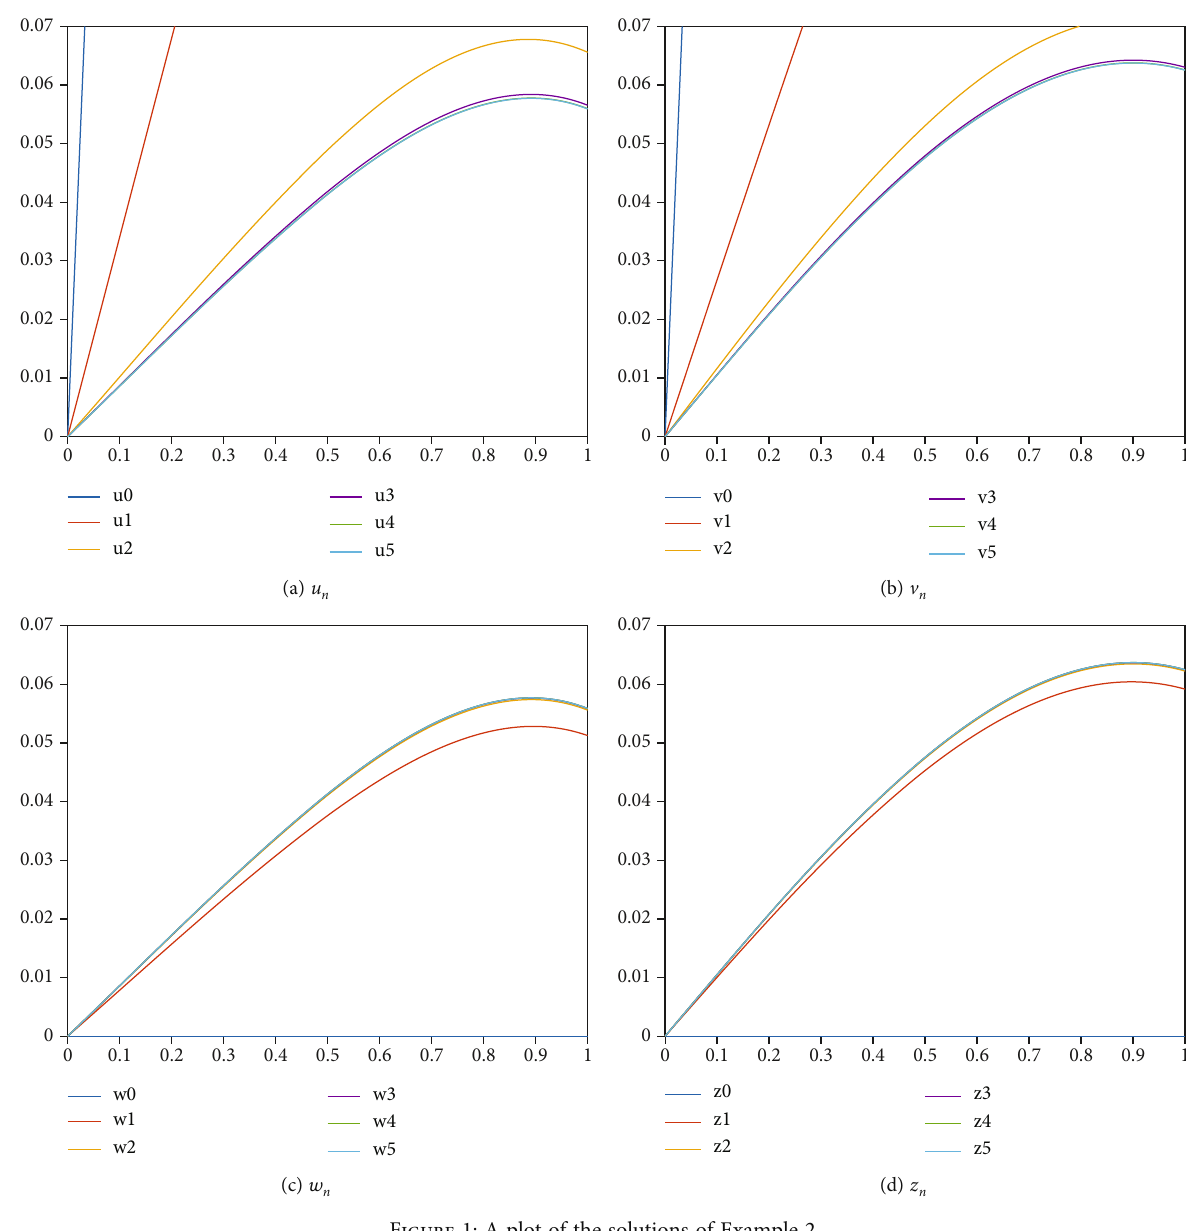
Figure 1: A plot of the solutions of Example